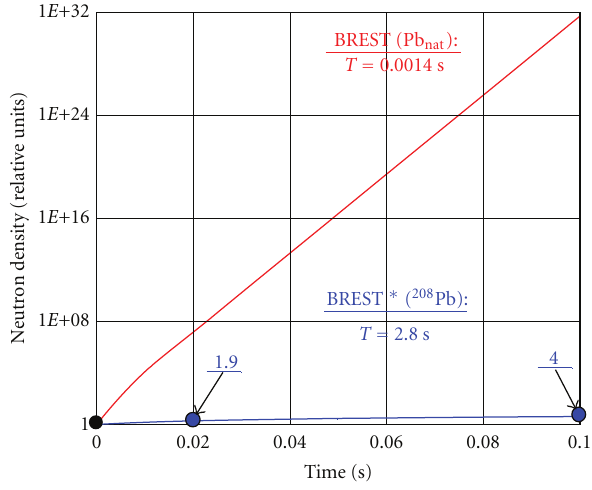
Figure 4: Reactor runaway without accounting for feedbacks induced by the stepwise insertion of positive reactivity ρ/β = 1 . 1 dollar.